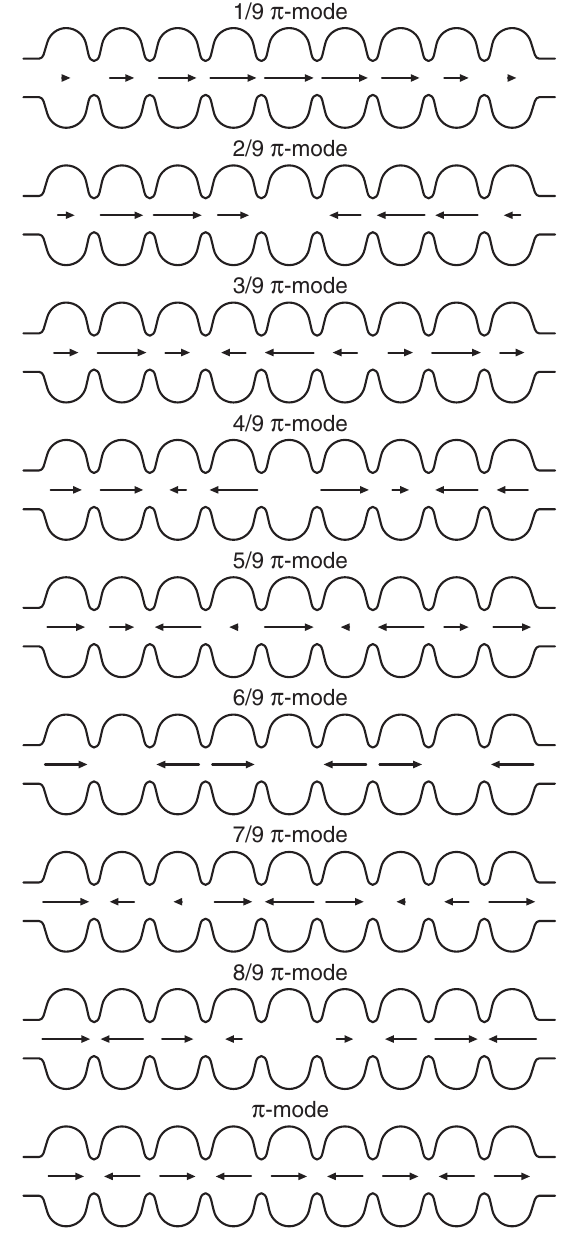
FIG. 2. The rf field amplitudes of the normal and fundamental modes (FMs) in